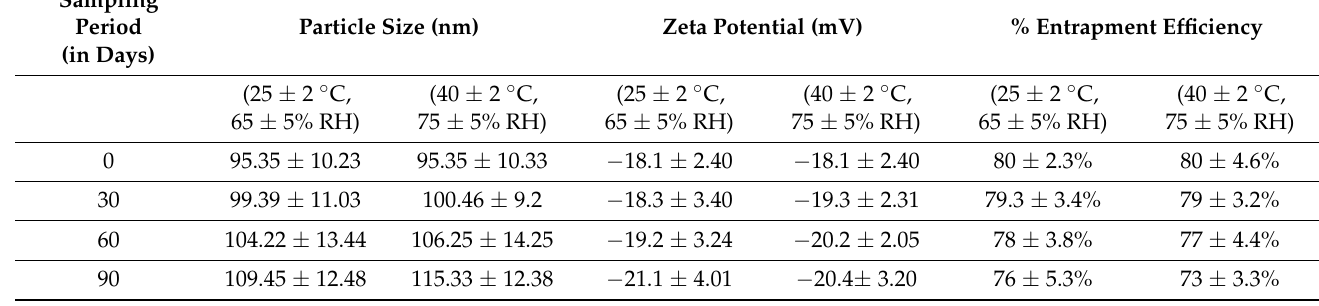
Table 8. Stability indicating data of Dox–Erlo-NP conjugates with regard to particle size, zeta potential, and % entrapment